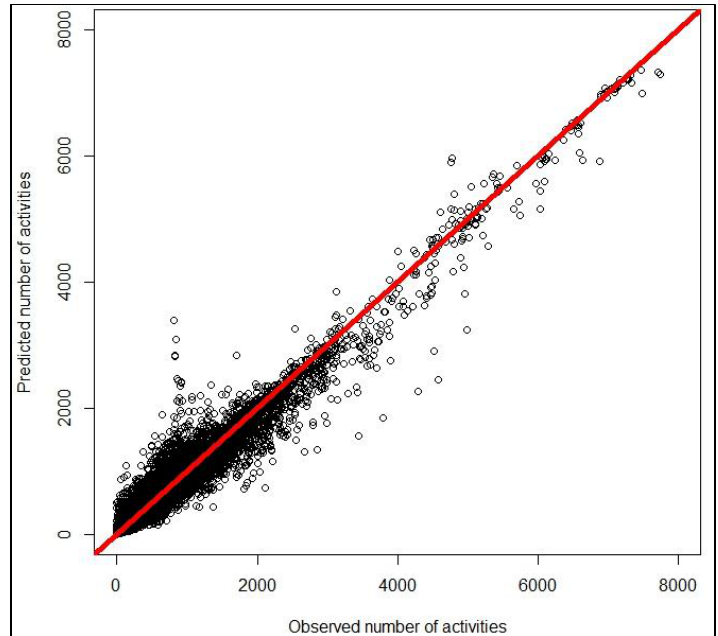
Figure 7. Predicted and observed number of non-commuting activities.